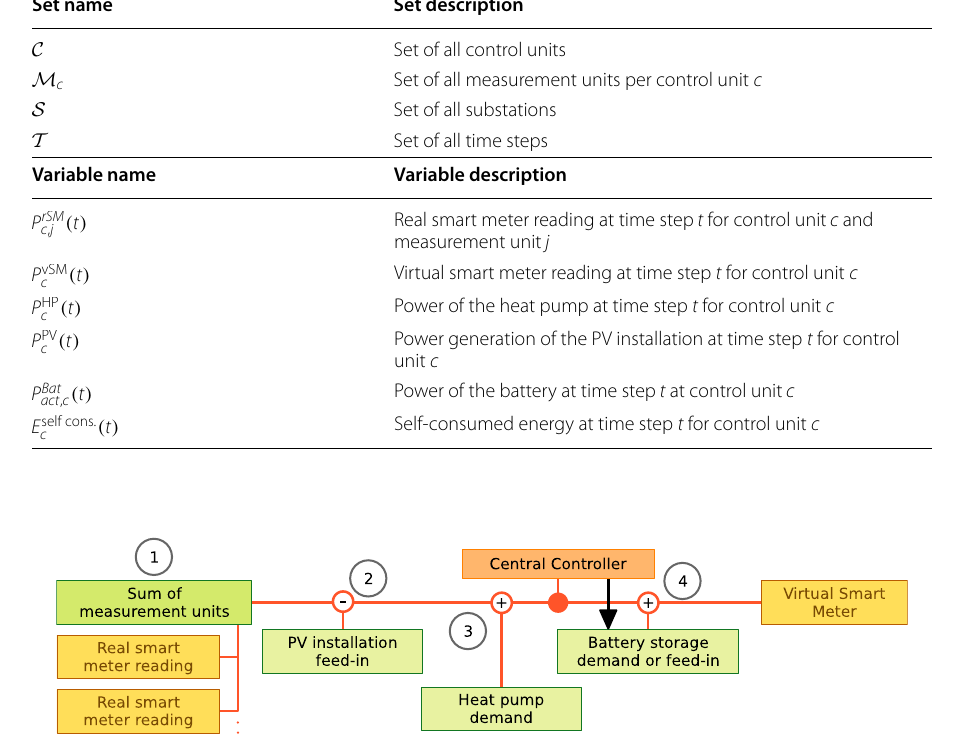
Fig. 3 Visualization of the virtual smart meter load computation and the ordering of component calculations inside of a control unit. The battery action is determined by the controller inside the